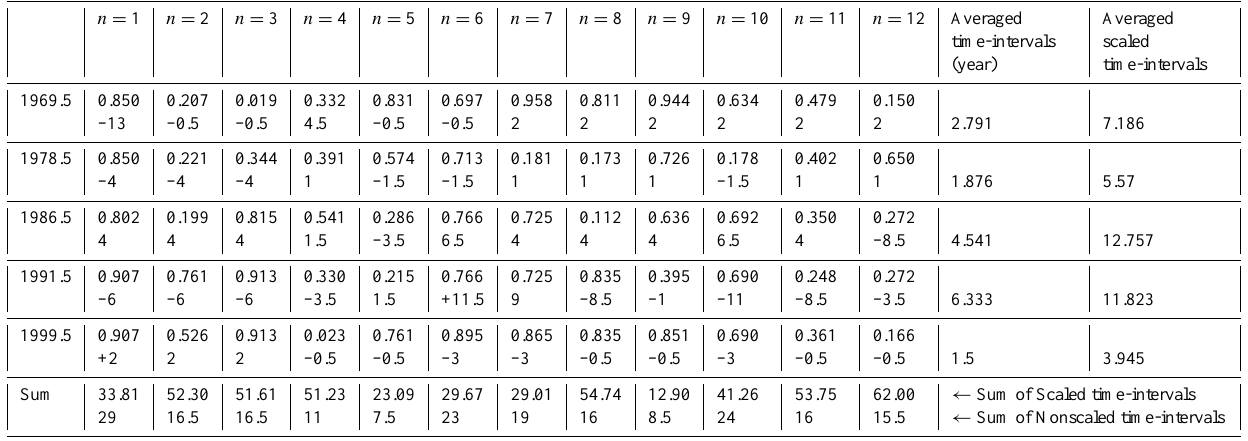
Table 2. Geomagnetic jerk dates correspondences to the R 3d n maxima. n = 1 Averaged